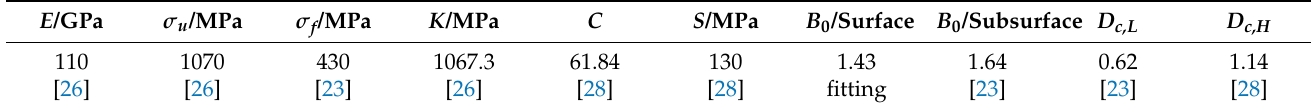
Figure 6. Fitting of fatigue damage parameters for the surface initiation. Table 2. The parameters of variable amplitude fatigue damage model.